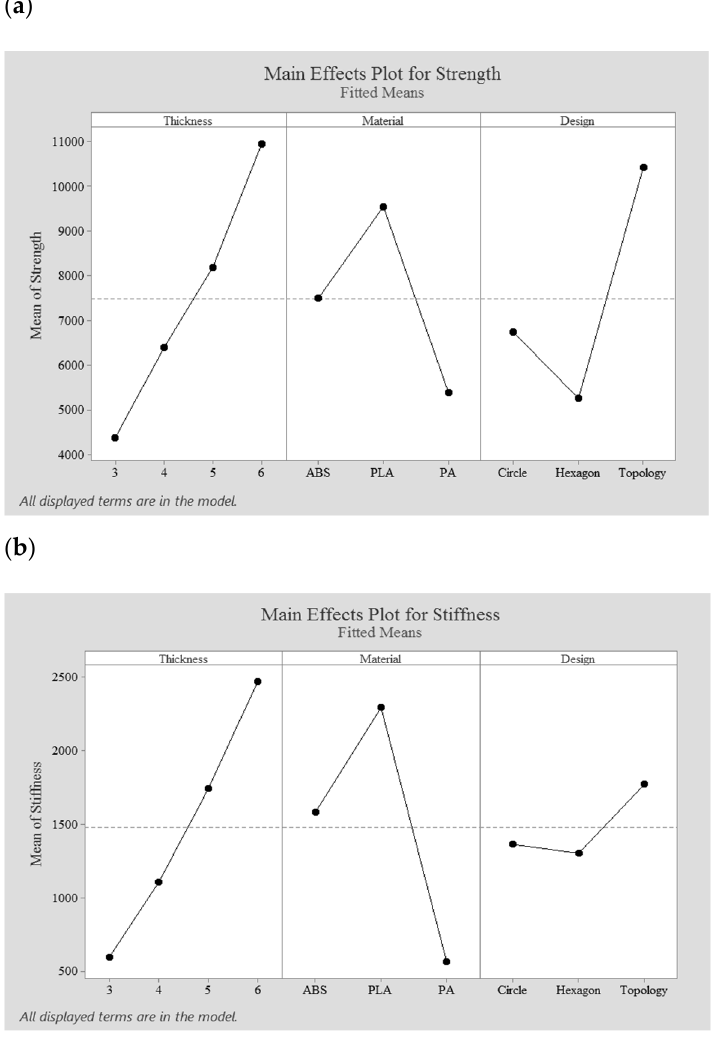
Figure 6 . The main effect plot; ( a ) for the strength response and ( b ) for the stiffness response.